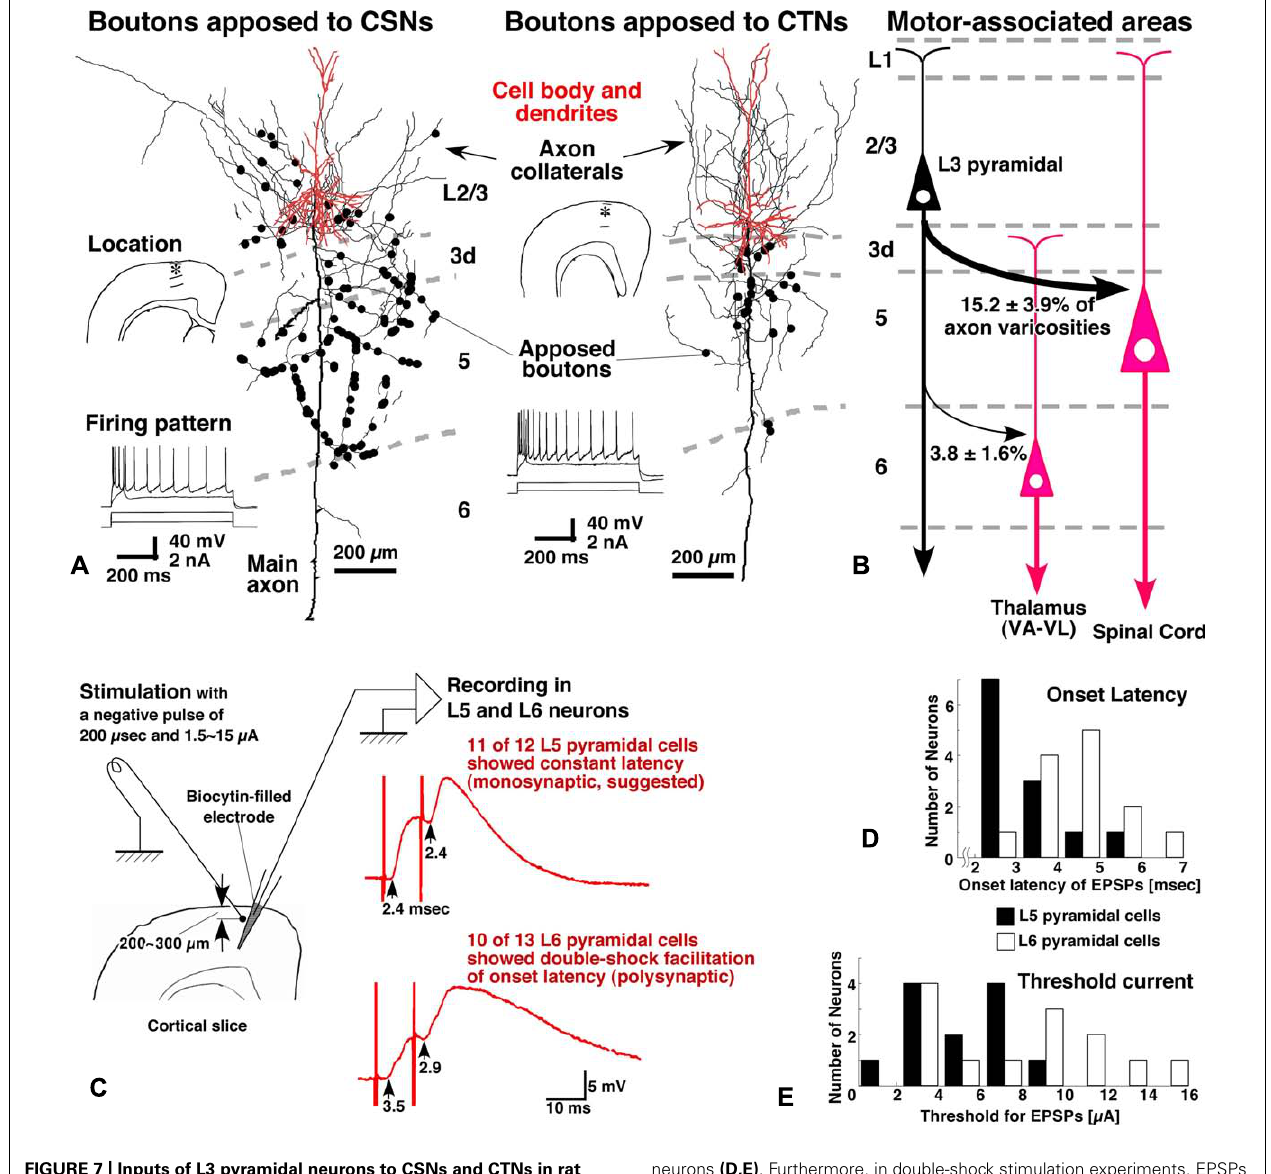
neurons (D,E) . Furthermore, in double-shock stimulation experiments, EPSPs in 11 of 12 L5 pyramidal neurons showed a constant latency, being a sign of monosynaptic inputs, whereas those in L6 pyramidal neurons displayed double-shock facilitation of onset latencies, indicating that the connection was polysynaptic (C) .These morphological and electrophysiological findings suggest that L6 pyramidal neurons do not receive strong monosynaptic inputs from L3 pyramidal neurons. (A,C–E) Modified with permission from Figures 4, 6, and 7 of Kaneko etal. (2000).